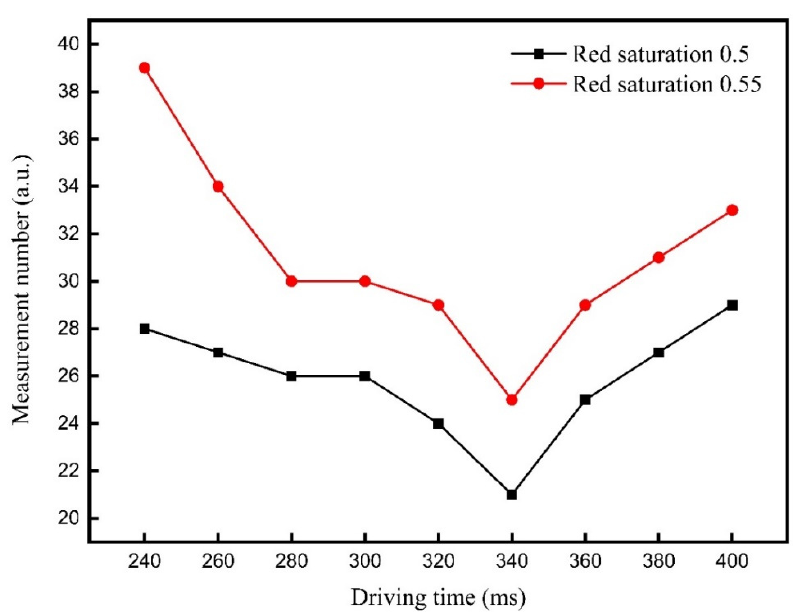
Figure 7. The response time of red saturation 0.5 and red saturation 0.55 driven by different 𝑇 (cid:3019)(cid:2869) values are shown in Figure 7. The response time of red saturation 0.55 and red saturation 0.5 de- creased with the increase of 𝑇 (cid:3019)(cid:2869) from 240 to 340 ms. Then, the response time of red saturation 0.55 and red saturation 0.5 increased with the increase of 𝑇 (cid:3019)(cid:2869) from 340 to 400